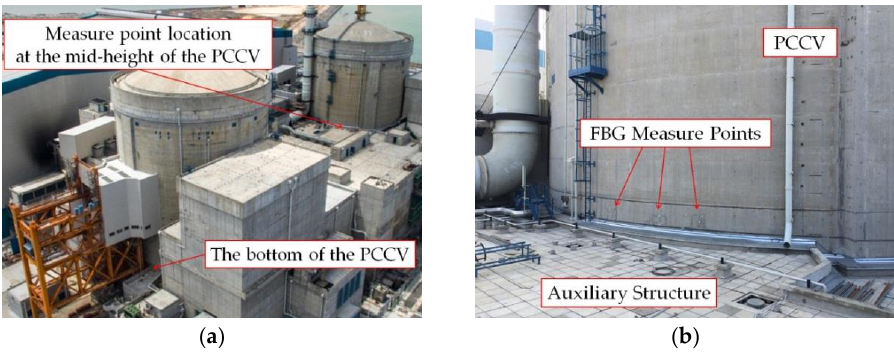
Figure 1. The location of fiber Bragg grating (FBG) measuring points on the prestressed concrete containment vessel (PCCV). ( a ) Prospect of the measuring points; ( b ) Close shot of the measuring points.